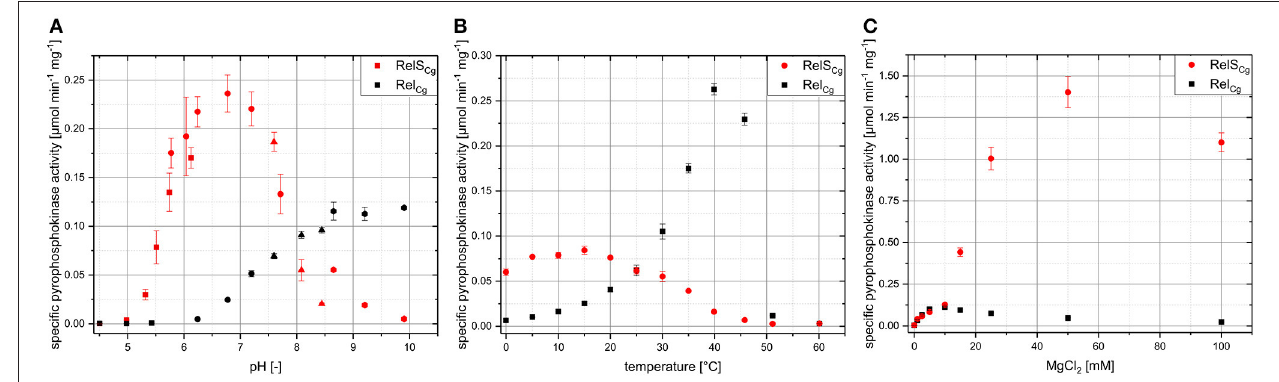
FIGURE 6 | Analysis of relevant reaction parameters on the activity of RelS Cg and Rel Cg . Specific pyrophosphokinase activities were determined by in vitro analysis under variation of pH-value (A) , temperature (B) , and MgCl 2 concentration (C) . The initial reaction mixture contained 50 mM Tris-HCl (pH 8.0), 5 mM MgCl 2 , 4 mM ATP, 4 mM GTP as well as 500 ng RelS Cg (257 nM) or Rel Cg (118 nM), respectively and was incubated for 4 h at 30 ◦ C. The various buffer systems (50 mM each) used to vary the pH value are illustrated by different icons: square: citrate buffer; circle: phosphate buffer; triangle: TRIS buffer; hexagon: ammonia buffer. Mean values and standard deviations shown were calculated from three